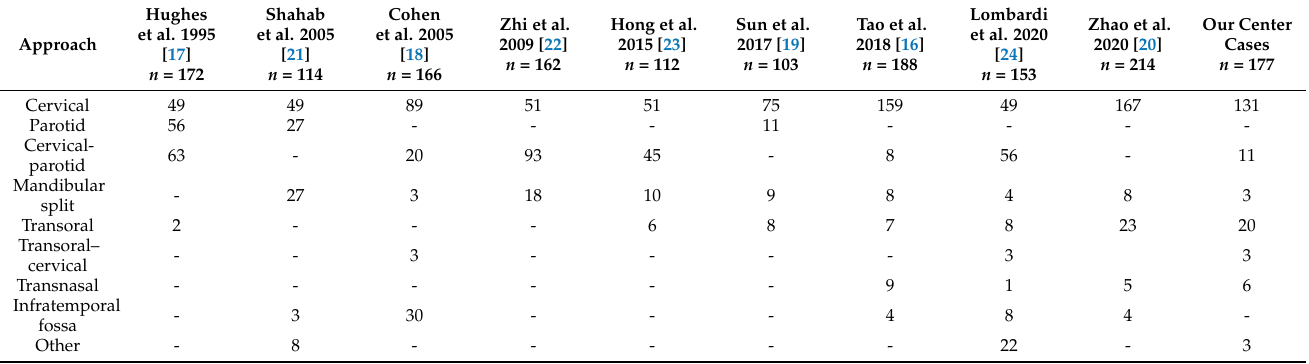
Figure 4. ( A ) Distribution of the different surgical approach; ( B ) Distribution of histopathology; ( C ) Distribution of complications. Table 2. Surgical